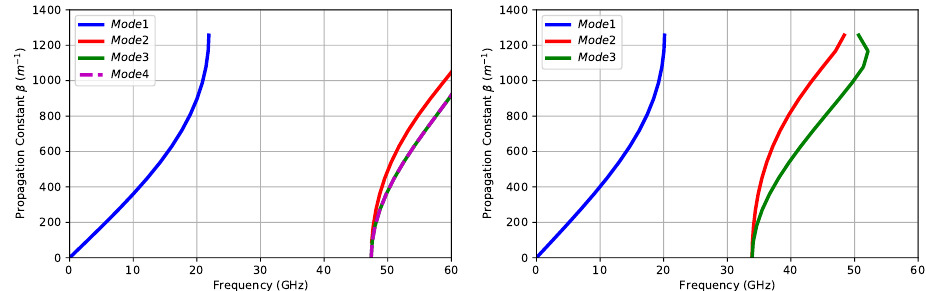
Figure 5. Dispersion diagrams of the unit cell pin configuration for air ( left ) and RT/duroid™ 5880LZ ( right